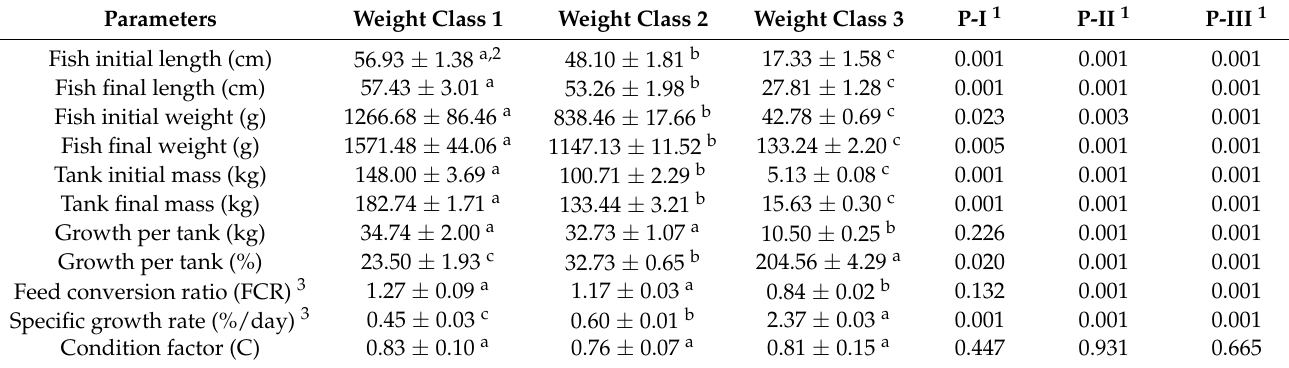
Table 1. Growth parameters (means ± SD) of African catfish of different weight classes (class 1 = large fish, class 2 = medium fish, class 3 = small fish) held in the intensive aquaculture unit (IAU) (49 days); different letters represent significant differences between the groups ( p < 0.05).